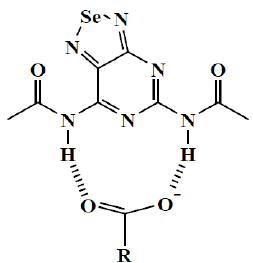
Figure 30: (a) Change of absorption spectra of 35 upon addition tetrabutylammonium acetate in acetonitrile; (b) Job plots determined by UV–vis method. (adapted from ref. 66(c)).